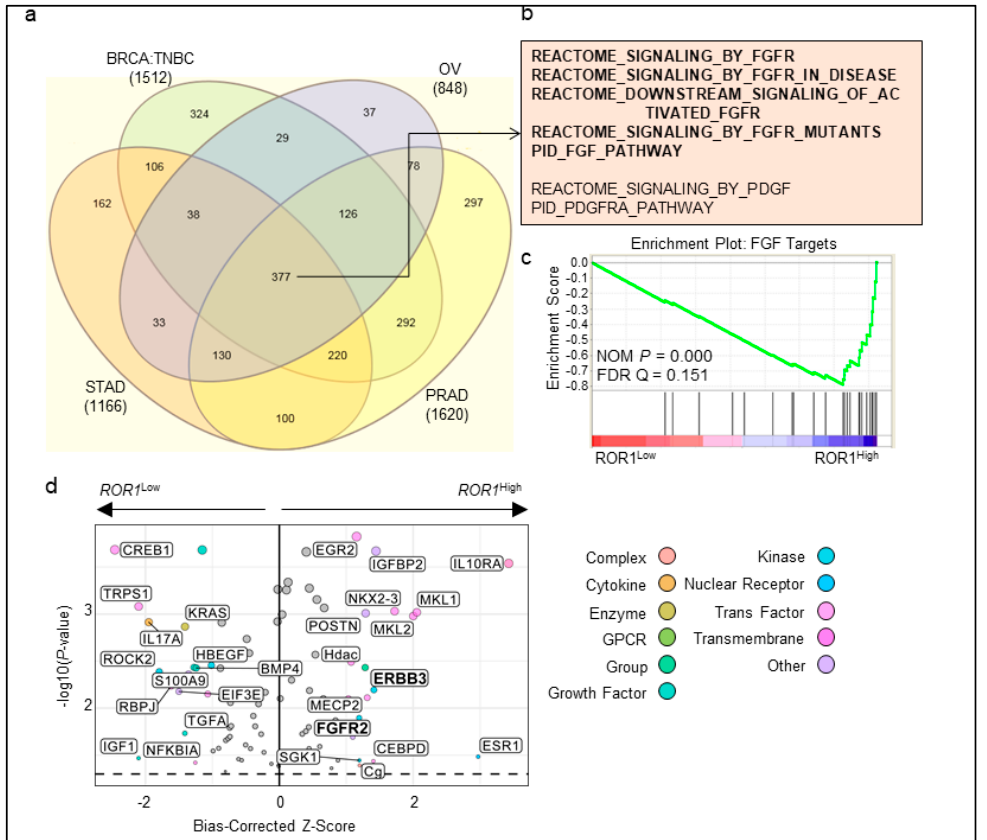
Figure 4. ROR1 is associated with FGFR signaling across different cancers. ( a–c ) Stomach adenocarcinoma (STAD: data from TCGA), triple-negative breast cancer (BrCa: data from GSE76275), ovarian (OV: data from TCGA) and prostate adenocarcinoma (PRAD: data from TCGA) were separated into low and high ROR1 expressing groups (77 samples with the lowest expression vs. 77 samples with the highest expression) and gene set enrichment analysis was performed. ( a ) Venn diagram of genesets significantly enriched (FDR < 0.25) in the ROR1 high group from each dataset. ( b ) Genesets related to FGFR and PDGFR receptor tyrosine kinase signaling pathways from the common 377 genesets in ( a ) are indicated. ( c ) Enrichment plot for FGFR geneset showing enrichment in ROR1-high expressing group in the BrCa TNBC dataset. ( d ) Ingenuity Pathway Analysis (IPA) for upstream regulators comparing the ROR1 high versus ROR1 low tertiles in the BLBC samples in the TCGA. Labeled regulators have a –log10 ( p -value) > 1.3, the equivalent of p < 0.05, and bias-corrected Z -scores > 1.2.